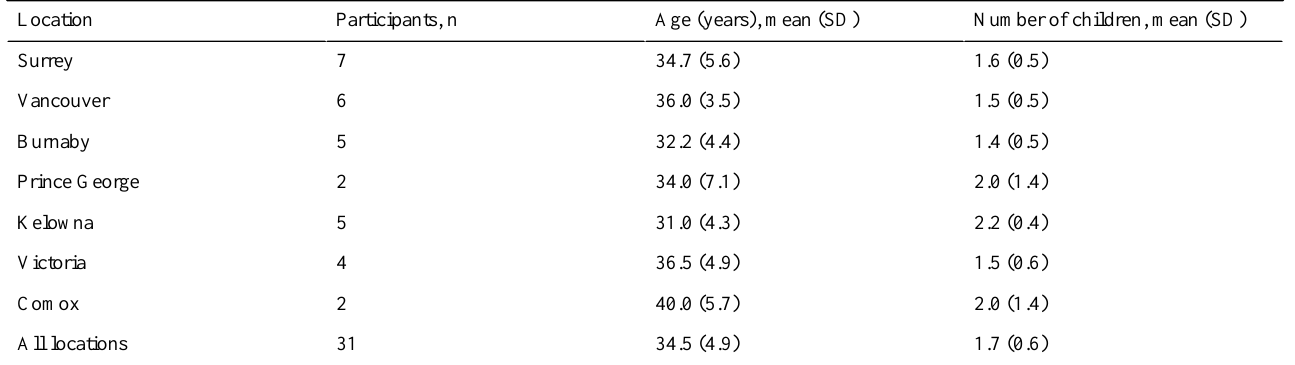
Table 1. Number of participants in each group